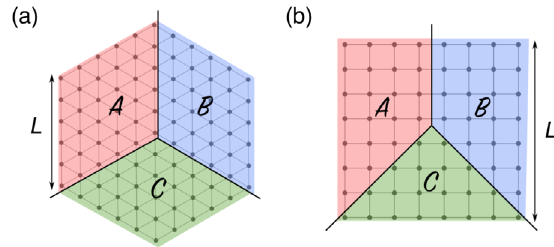
FIG. 4. Tight-binding models and the respective tripartition for D ¼ 2 numerical study. (a) Triangular lattice with symmetric tripartition. Every angle at the triple contact is 2 π = 3 . (b) Square lattice with a different geometry of tripartition. Angles at the triple contact are 3 π = 4 , 3 π = 4 , and π = 2 . Open-boundary condition is implemented for